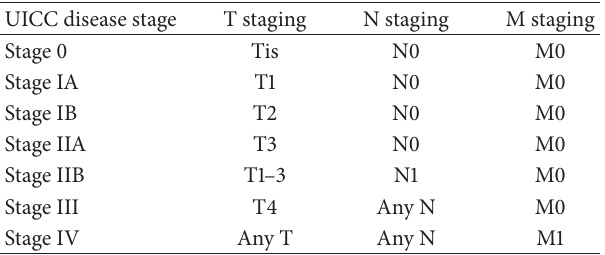
Table 1: Staging group for